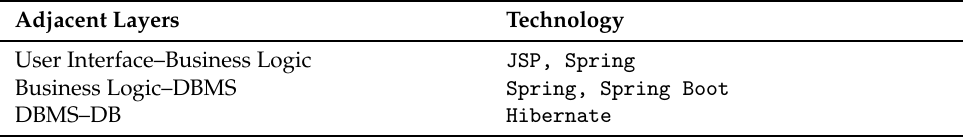
Table 2. Communication software between adjacent